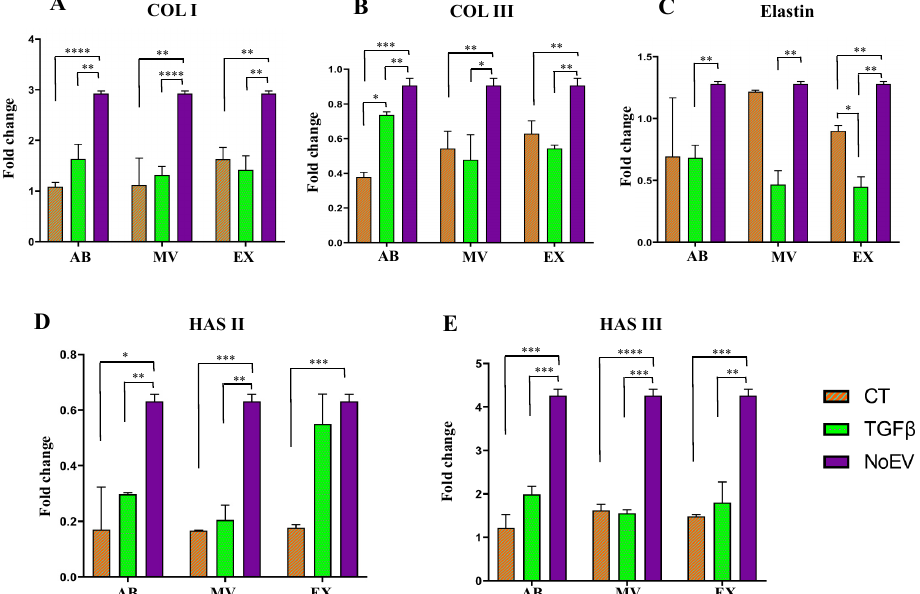
Figure 4. Induction of ECM gene expression in fibroblasts by EVs from TGF β -stimulated UCMSCs and normal UCMSCs. There was no difference in COL I, COL III, Elastin, HAS II, and HAS III mRNA levels in dermal skin fibroblasts between EVs from TGF β -stimulated UCMSCs and normal UCMSCs. Only COL III and Elastin in fibroblasts stimulated by ABs from TGF β -stimulated UCMSCs and EXs from normal UCMSCs expressed higher levels compared to the normal condition and TGF β -stimulated condition, respectively. ( A ) mRNA levels of COL I. ( B ), mRNA levels of COL III, ( C ) mRNA levels of Elastin, ( D ) mRNA levels of HAS II, and ( E ) mRNA levels of HAS III detected in fibroblasts under stimulation of EVs. CT: control group (EVs from UCMSCs cultured in normal condition), TGF β : EVs from TGF β -stimulated UCMSC group, NoEV: EV-depleted cell culture media, AB: apoptotic body, MV: microvesicle, EX: exosome. N = 3, * indicates p < 0.05, ** indicates p < 0.01, *** indicates p < 0.001, **** indicates p < 0.0001.